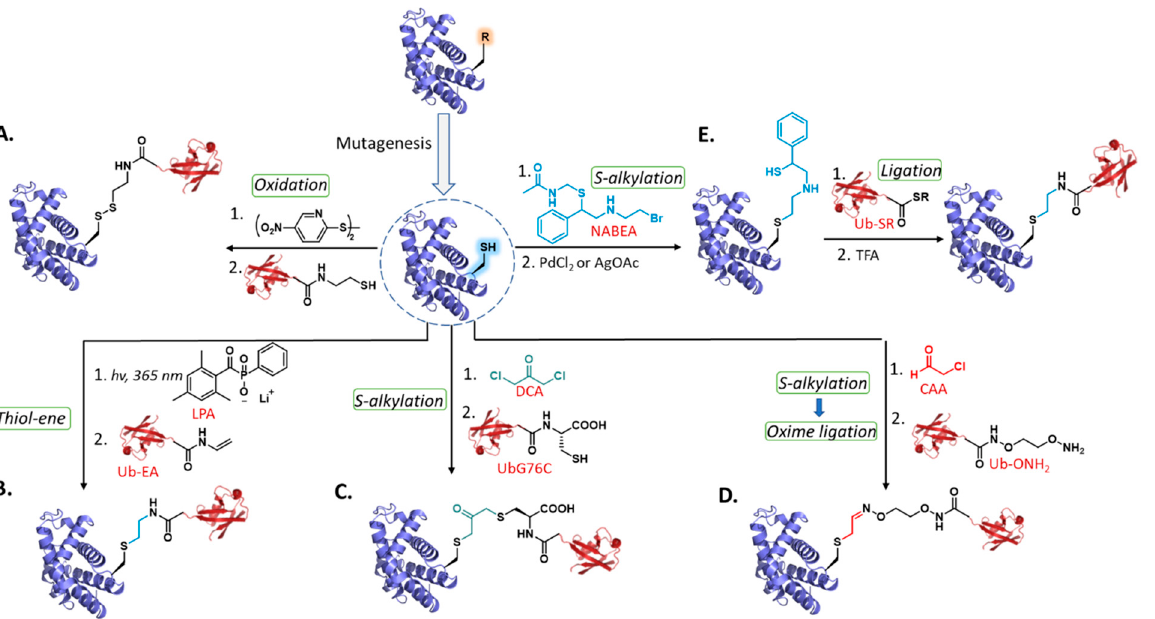
Figure 3. Chemical protein ubiquitylation. Chemoselective ubiquitylation: ( A ) oxidation; ( b ) thiol–ene addition; ( C ) S -alkylation; ( D ) S -alkylation coupled with oxime ligation; ( E ) S -alkylation coupled with NCL.